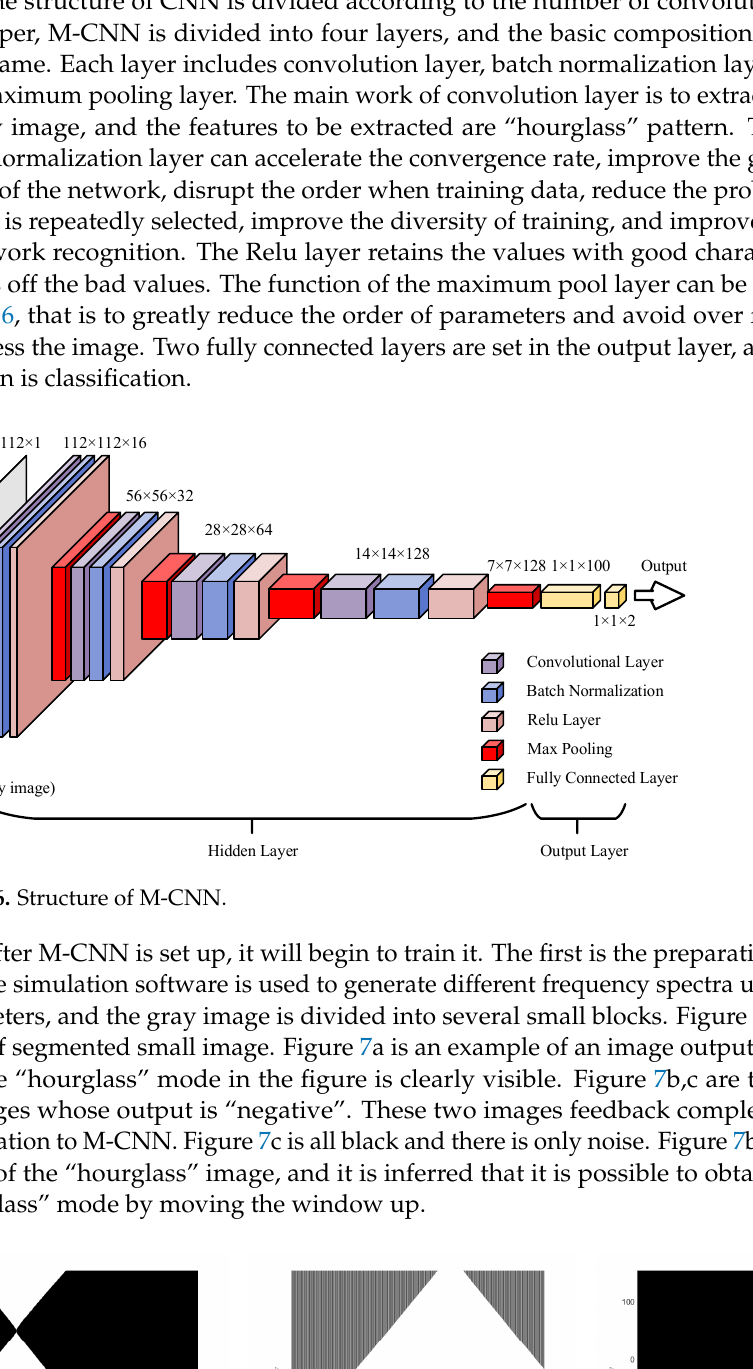
Figure 6 is the structure of M-CNN. The input is the gray image obtained by processing 286 the spectral map of the reflected signal. The pixels of the grayscale image are 112 scale of the image input section is expressed as 112 results of M-CNN, one is "positive" and the other is "negative". The output result is related 289 to whether the input image can be recognized.